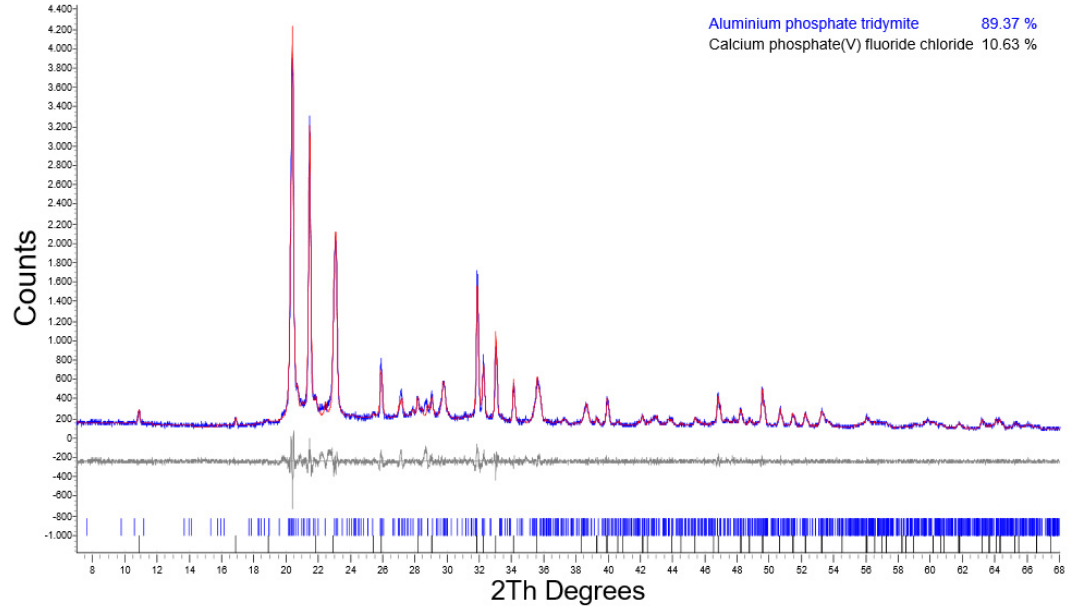
Figure A7. Rietveld refinement plot for 72/SAR1: the vertical lines provide the positions of all possible Bragg reflections for the aluminum phosphate tridymite phases, according to data presented in the literature [55]. Calcium phosphate (V) fluoride chloride (database_code-ICSD 203026). The values of the standard agreement indices are Rp—6.86, Rwp—8.94, Rexp—5.77, GofF—1.55.